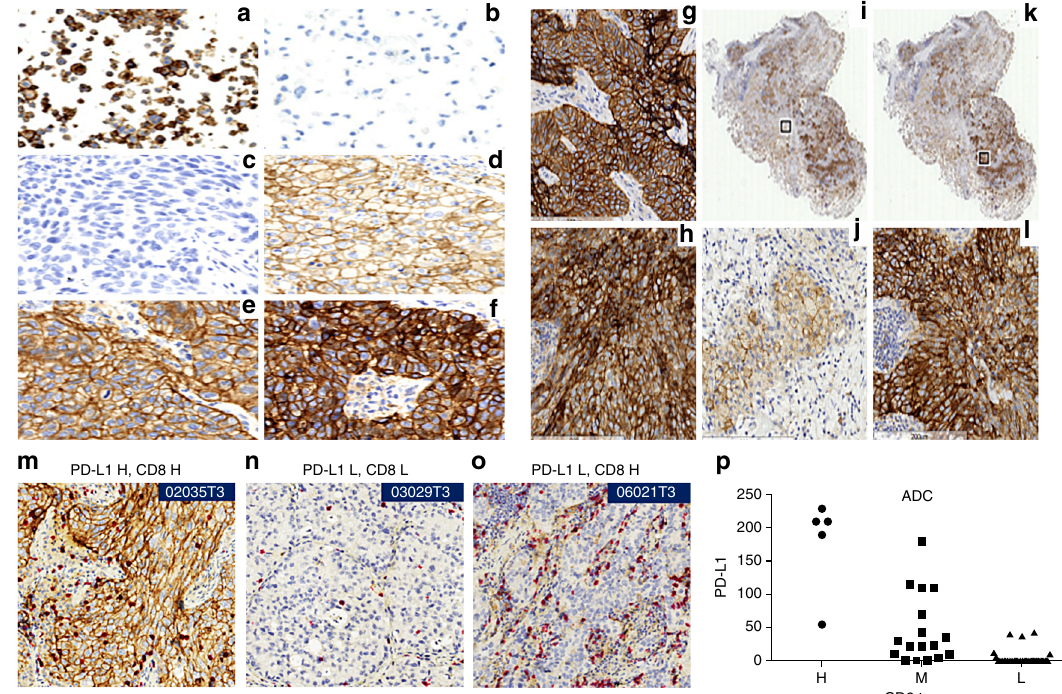
Fig. 6 Immunohistochemistry staining of PD-L1 and CD8. a Membrane staining (3 + ) was seen in positive control cells (HDLM-2). b No staining was seen in negative control cells (PC3). c – f Representative images of membrane staining on tumor cells were shown with different signal intensities: c No staining. d Low/1 + staining, e Medium/2 + staining. f High/3 + staining. Example of heterogeneous IHC staining: g Strong staining of PD-L1 from SQCC ( h ) Strong staining in ADC. i – l Heterogeneous expression of PD-L1 from the same tissue. i , k are the same tissue; two regions are selected (boxed). j Zoomed-in region of i . l Zoomed-in region of k . Correlation between PD-L1 and CD8. m – o Representative images of PD-L1/CD8 both high, both low and PD-L1 L/CD8 H. p Correlation between CD8 positivity and PD-L1 expression was observed in ADC (ANOVA p -value = 8.76e-13, F = 50.25, DF = 2). Source data are provided as a Source Data fi